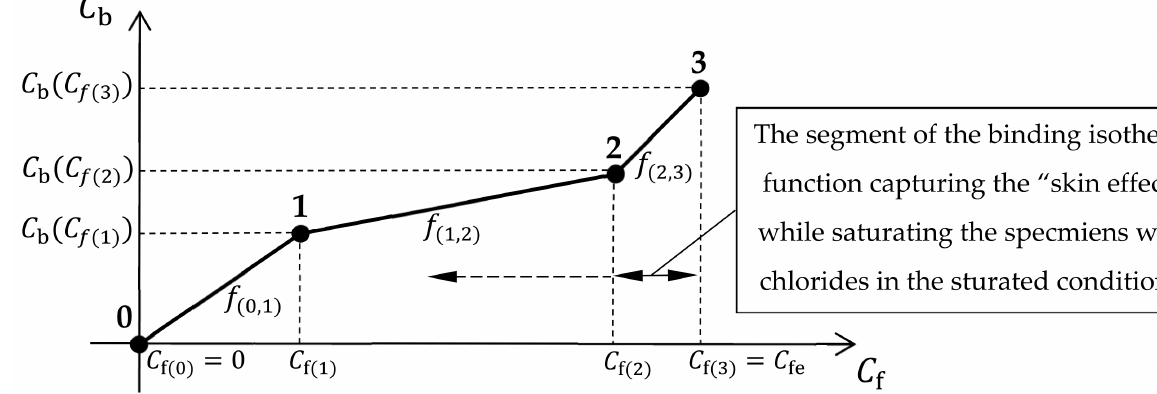
Figure 3. Illustration of chloride binding isotherm according to Equation (21) for n = 3. Isotherm parameters known according to the experimental conditions: C f ( 0 ) and C f ( 3 ) . Isotherm parameters to be determined from the inverse problem: C f ( 1 ) , C f ( 2 ) , C b